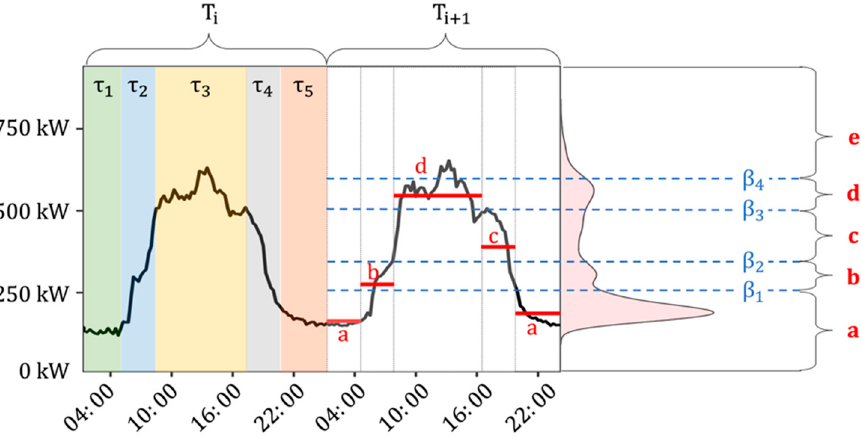
Figure 2. Example of an adaptive symbolic aggregate approximation (aSAX) process applied to an electrical load time series (T = 24 h, W = 5, α = 5).